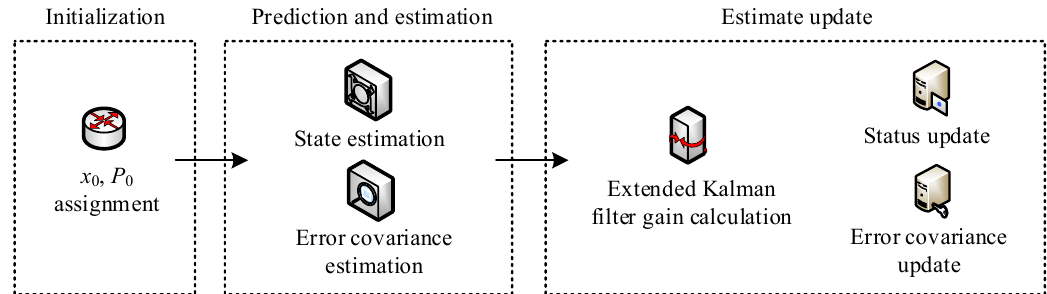
Figure 2. Operation principle of EKF model.